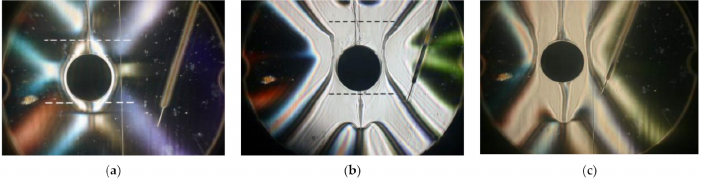
Figure 3. Schlieren images of periodic flows induced by oscillating sphere ( D = 4.5 cm), ( a – с )— T b = 11.2, 7.3, 11.2 s; A = 1, 2.8, 2.8 cm, ω / N = 0.73,